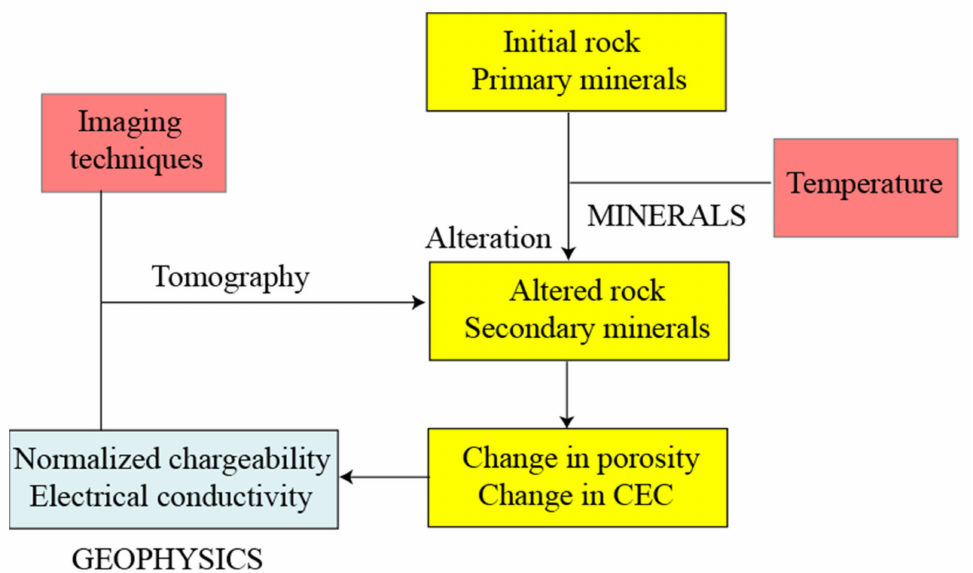
Figure 3. Sketch of the relationships between alteration and geophysics. Alteration modifies the porosity and CEC of (volcanic) rocks. In turn, this modifies the electrical conductivity and normalized chargeability of these rocks in a predictable way. This strong effect can be remotely observed using induced polarization tomography at any scale. This implies that induced polarization can be used to image alteration in volcanic areas and geothermal